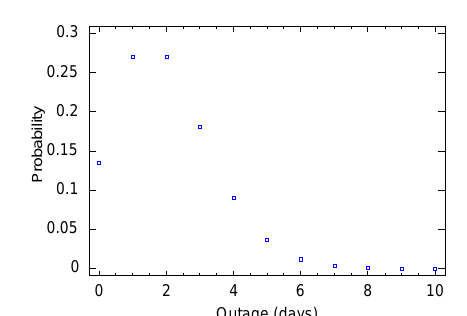
figure 4. probability mass function of the random duration of outage, 